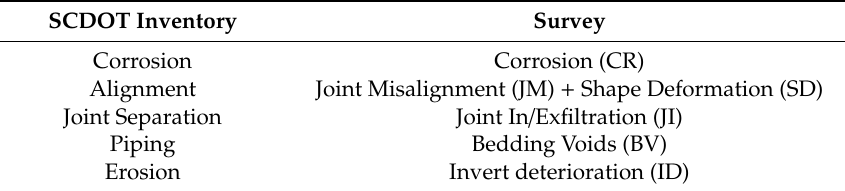
Table 3. Defect mapping for CMP culverts.